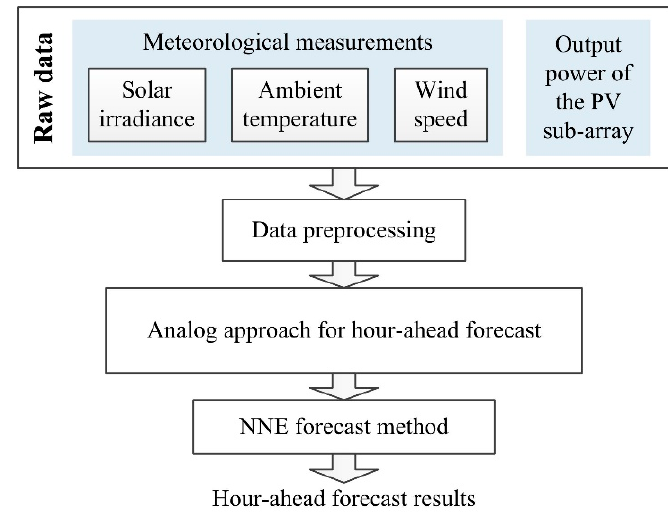
Figure 2. Overview of the proposed analog ensemble PV power forecasting method for hour-ahead forecast.